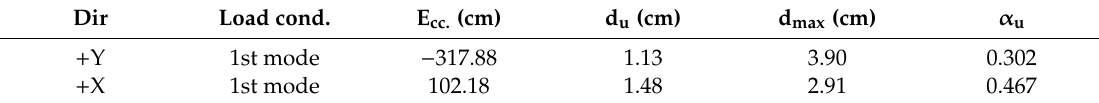
Figure 9. Pushover curves for the worst load condition in the X ( a ) and Y ( b ) directions. Table 3. Results related to the worst load conditions deriving from pushover analysis.